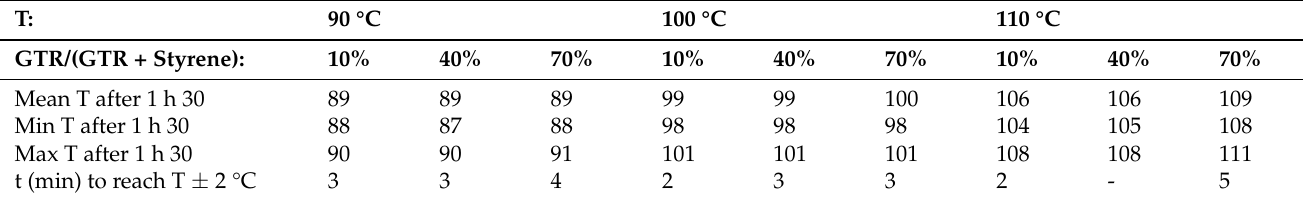
Table 3. Temperature control in the small-sized system (BPO/styrene = 5.5%